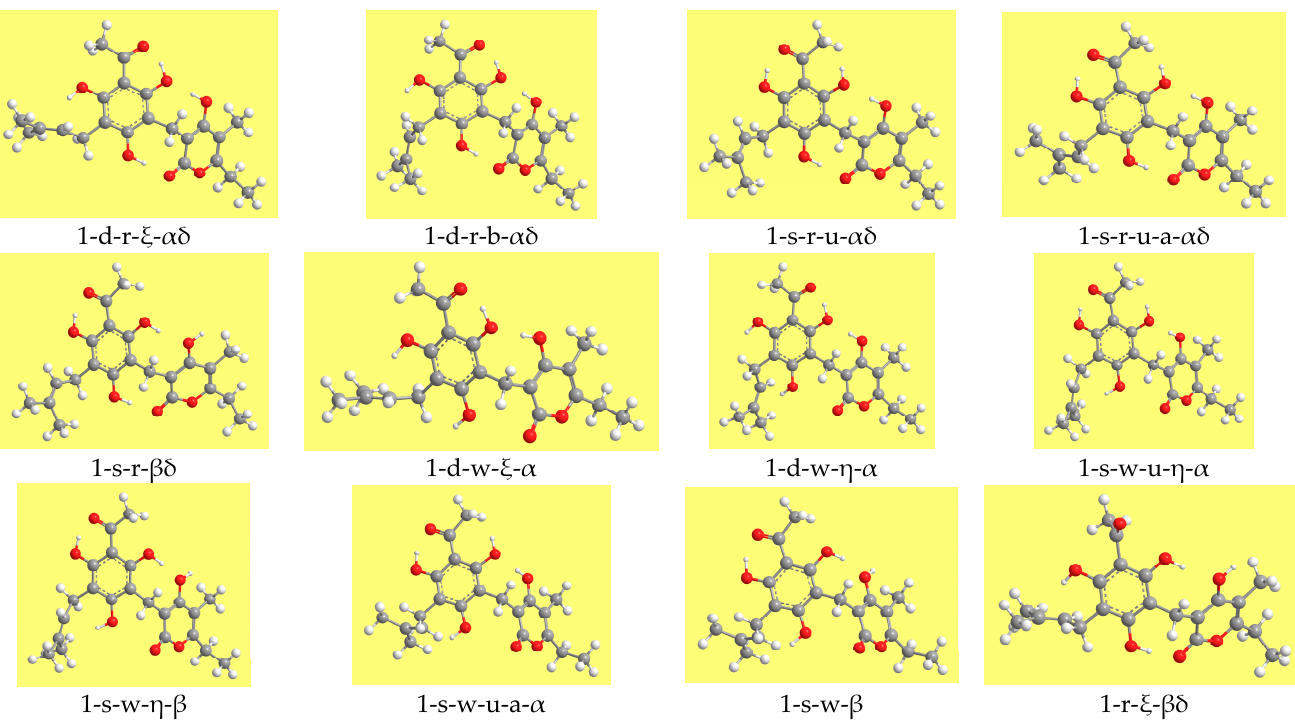
Figure 3. Illustrative images of different types of conformers of the arzanol molecule, considering relevant conformers of the series denoted by the number 1.